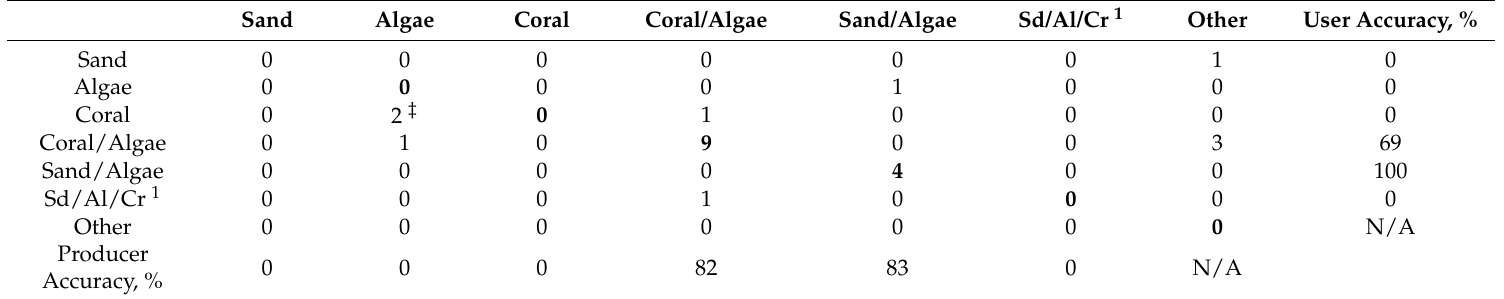
Table 5. Error matrix for the PRISM image of Heron Reef using the standard implementation of the BRUCE model using 11 endmember combinations. The “other” class contains output classes from BRUCE such as Sand/Coral, Algae/Seagrass and Sand/Seagrass, which do not match the categories from the benthic validation data. The diagonals of this matrix are pixels correctly classed and are presented in bold, while non-diagonal elements represent false positives. The overall accuracy of the classification from BRUCE is 57%.